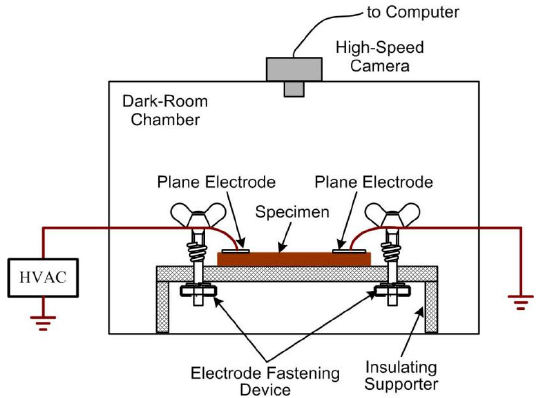
Figure 1. Experimental setup schematics.